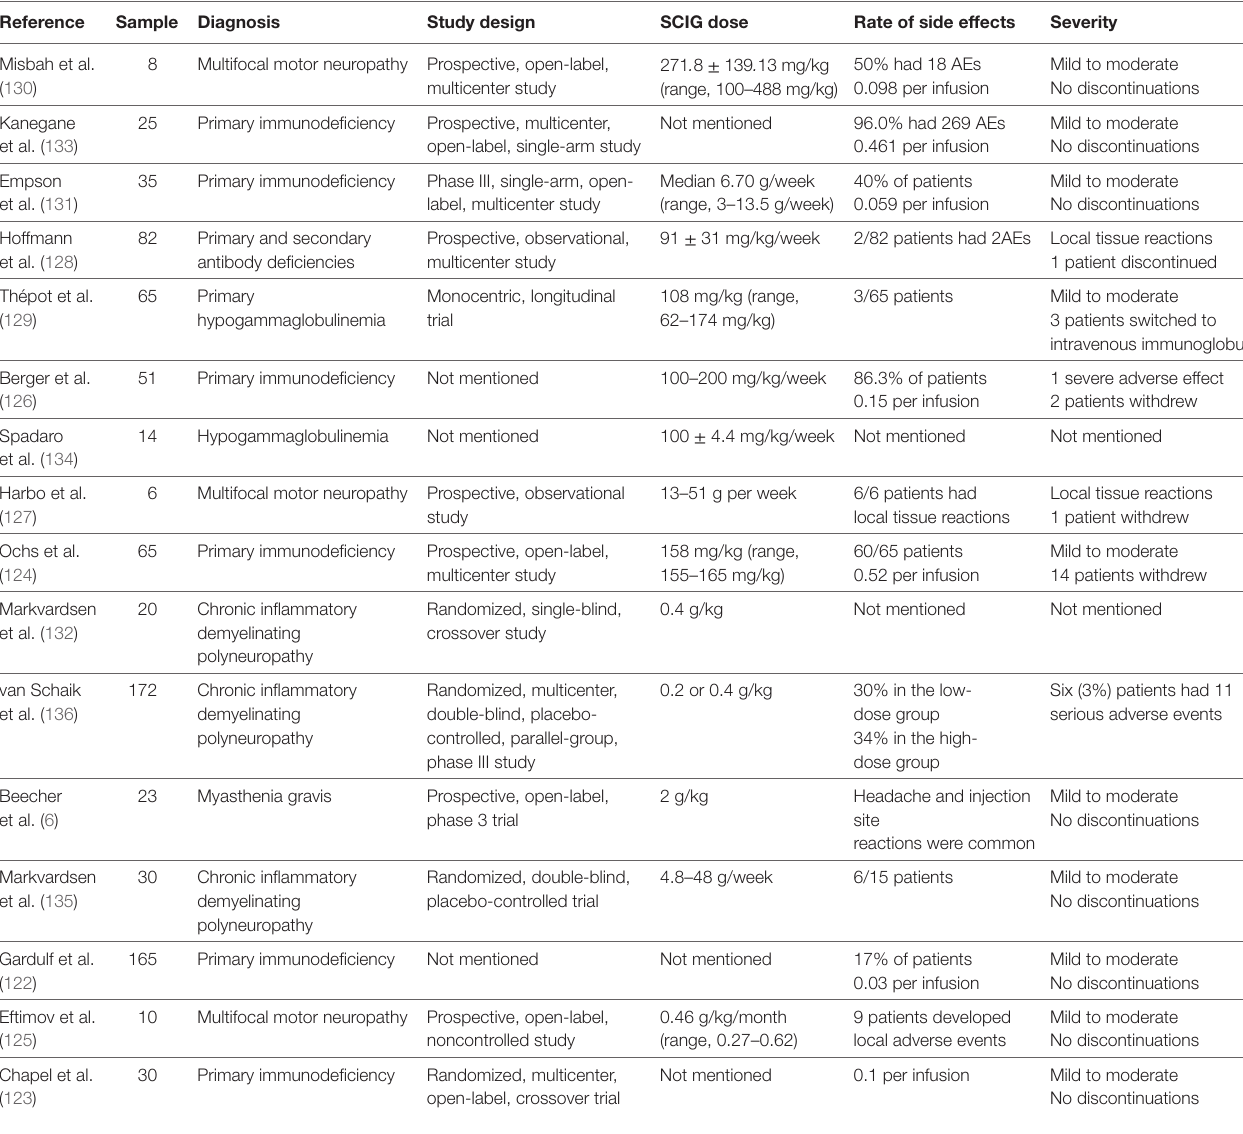
TAbLe 3 | Subcutaneous immunoglobulin (SCIG) treatment in a variety of